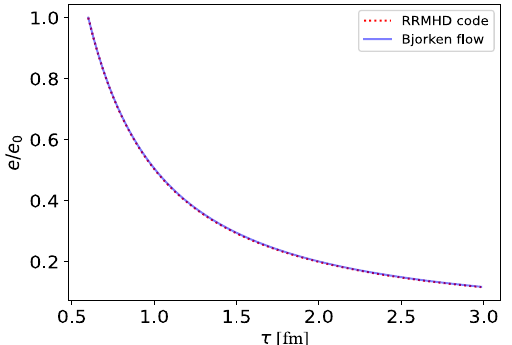
Fig. 14 The energy density of the fluid is displayed as a function of τ in the magnetized Bjorken flow